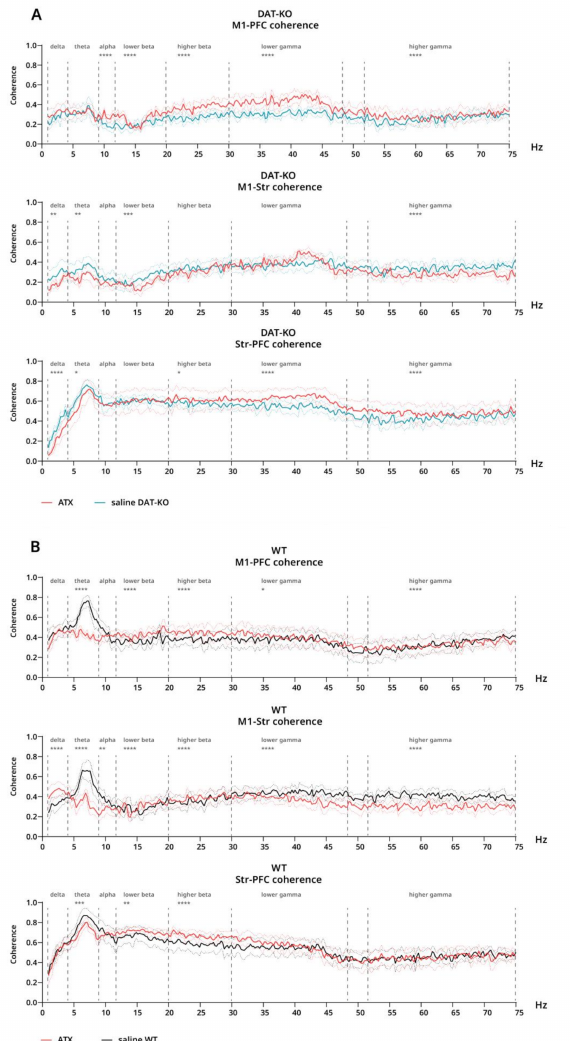
Figure 7. Coherence of brain activity of DAT-KO and WT rats after saline and atomoxetine injections. Interareal coherence is presented for pairs of brain areas: motor cortex (M1), prefrontal cortex (PFC) and striatum (Str). ( A ) Coherence after saline (teal) and ATX (red) in DAT-KO. ( B ) Coherence after saline (black) and ATX (red) in WT. Degree of coherence is expressed in fractions of one. Data are presented as mean (solid line) ± SEM (dotted line). Dashed lines represent electroencephalographic rhythms: delta (0.9–3 Hz), theta (4–8 Hz), alpha (9–11 Hz), lower beta (12–19 Hz), higher beta (20–29 Hz), lower gamma (30–48), higher gamma (52–74 Hz). * p < 0.05; ** p < 0.01; *** p < 0.001; **** p < 0.0001; two-way